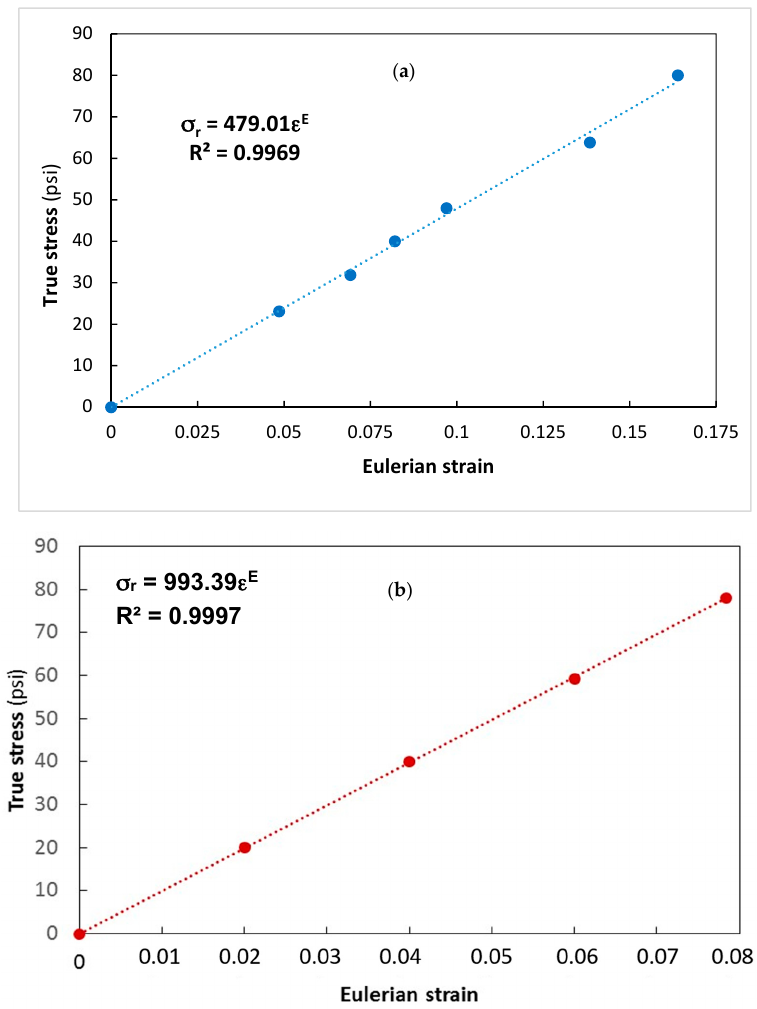
Figure 16. Results of the tensile tests utilized to determine: ( a ) elastic constant C 1E ; ( b ) elastic constant C 2E of urethane